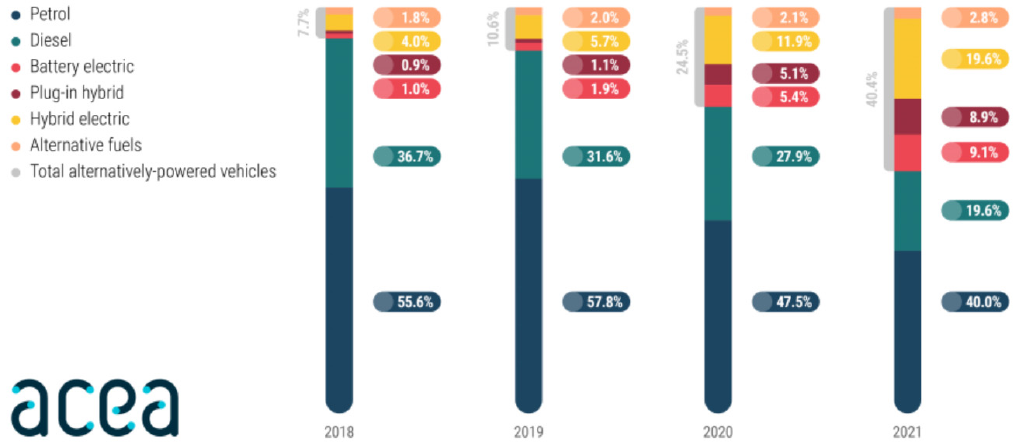
Figure 3. Market share of new vehicles in the EU by fuel type from 2018 to 2021.